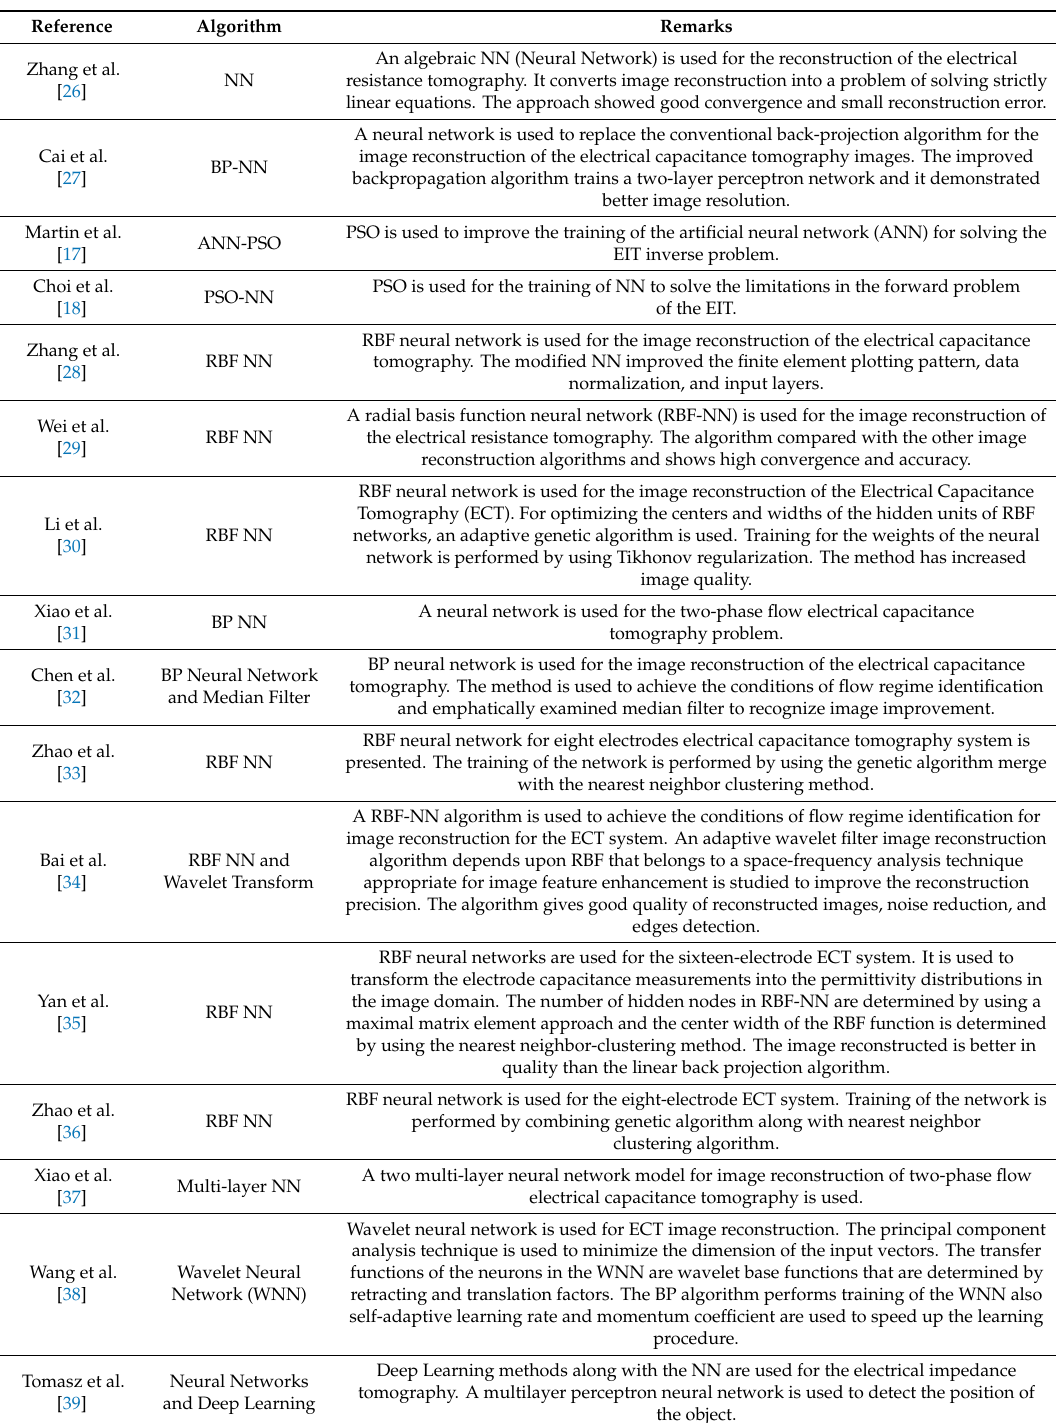
Table 2. Overview of papers using the neural network approach for solving the inverse